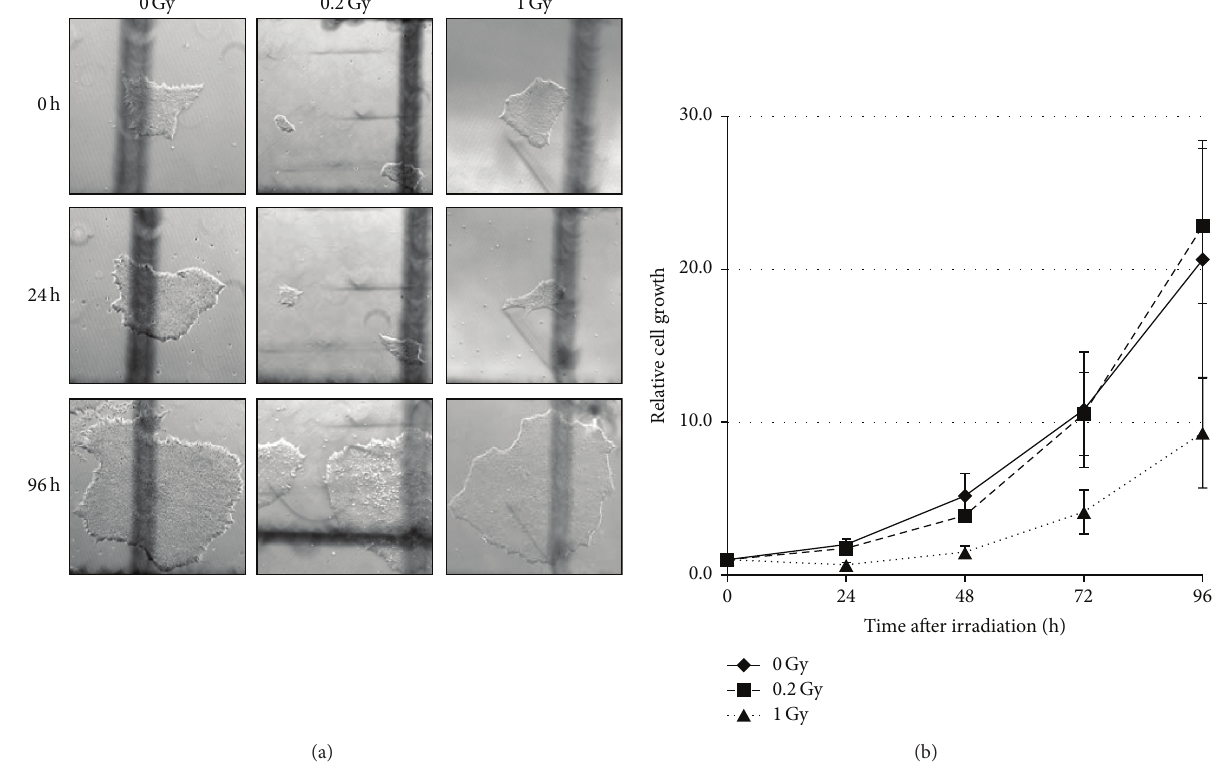
Figure 2: H14 human embryonic stem cell growth after exposure to ionizing radiation. (a) Microscopic images of representative colonies at 0, 24, and 96 hours after exposure to 0, 0.2, or 1Gy of ionizing radiation. (b) Cell growth curves of H14 human embryonic stem cells irradiated with 0, 0.2, or 1.0 Gy. The area of all colonies was normalized to 1 at the 0-hour time point. Averages of the measurement of 20 colonies are presented; error bars represent standard deviation.